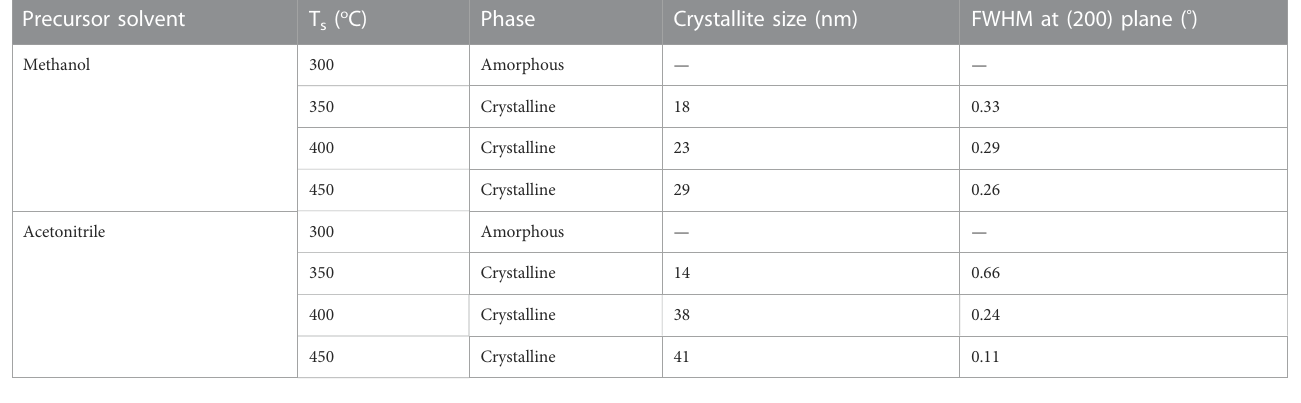
TABLE 1 In fl uence of deposition temperature and precursor solvent on the crystals structure NiO x thin fi lm, obtained from XRD analysis. Precursor solvent